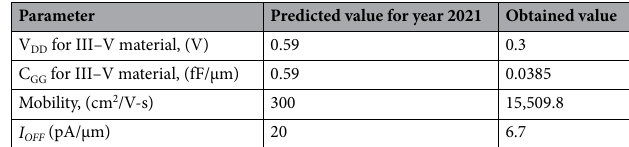
Table 1. ITRS 2013 (predicted LP technology requirements of multi-gate (MG) FET devices for year 2021).